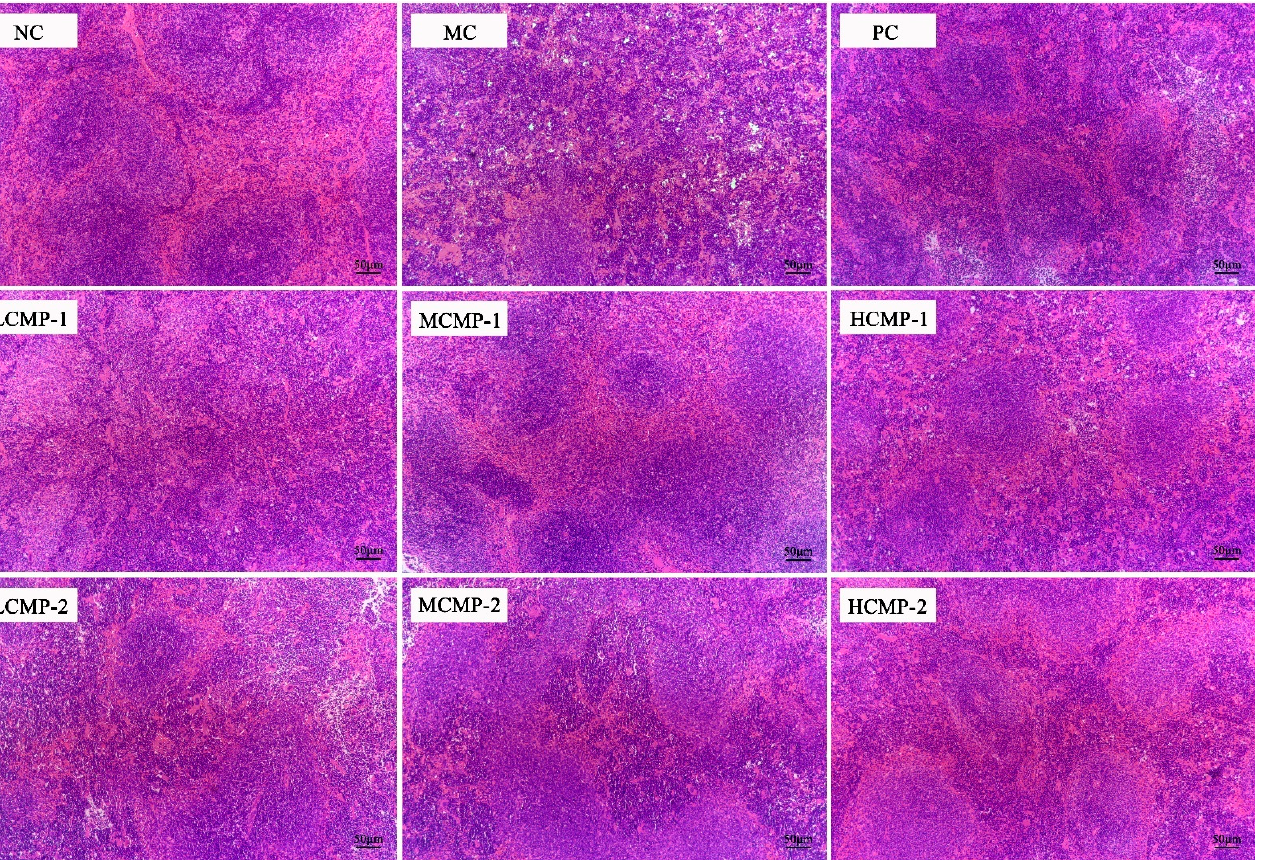
Figure 1. Effects of CMP-1 and CMP-2 on spleen index ( A ) and thymus index ( B ). The data were expressed as means ± SD (n = 10). Different superscript small letters (a–d) are significantly different ( p < 0.05).